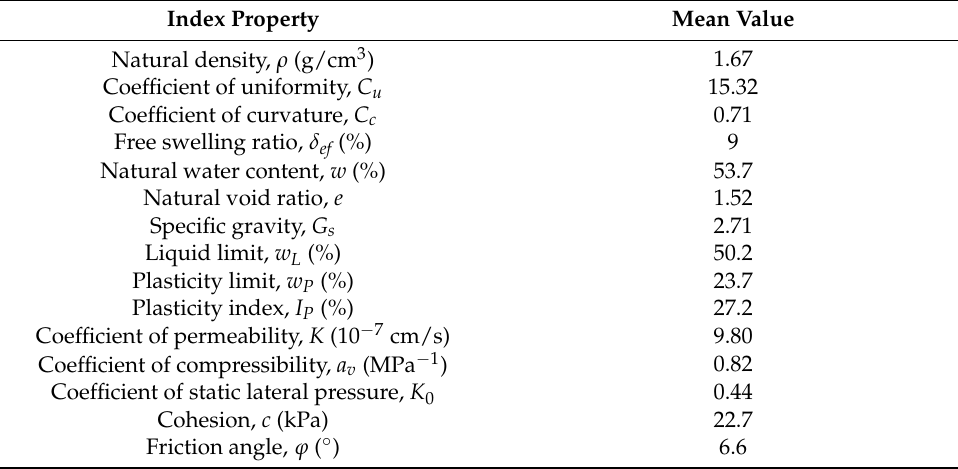
Figure 1. Particle size distribution of the tested soil. Table 1. Physico-mechanical indices of the tested soft